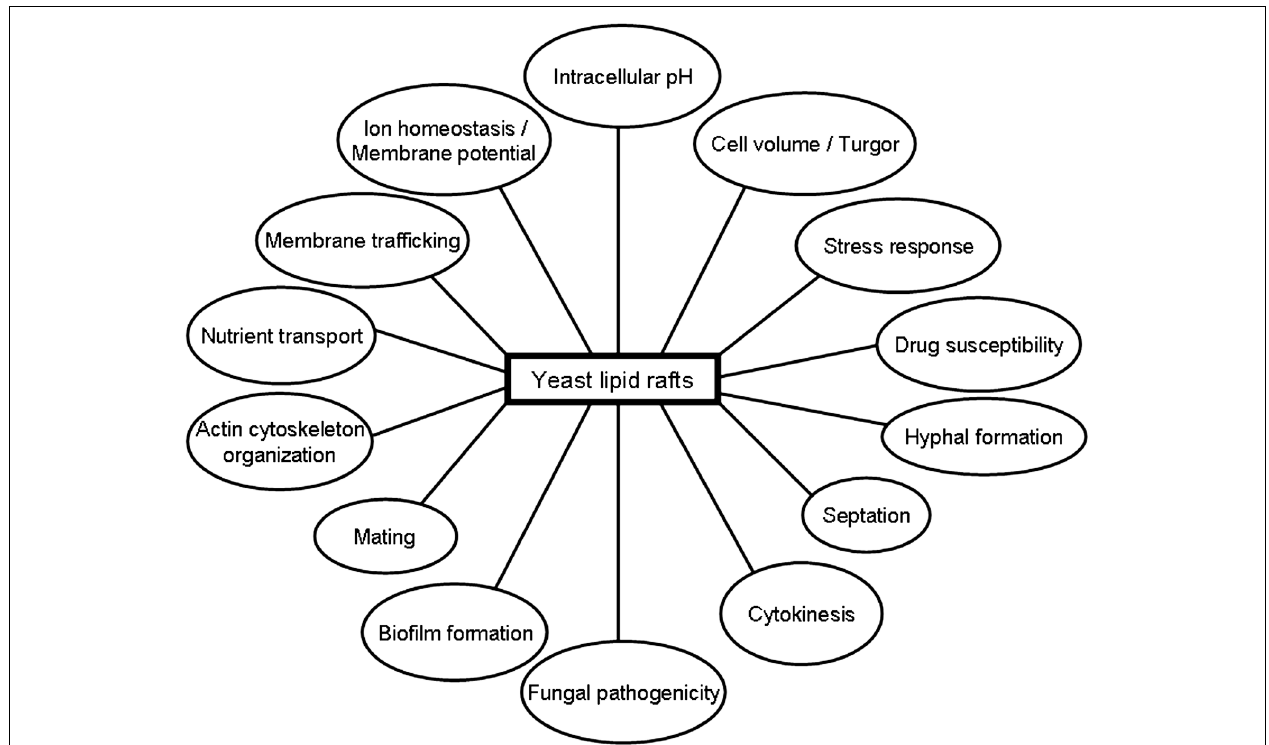
FIGURE 2 | Putative involvement of lipid rafts in different yeast